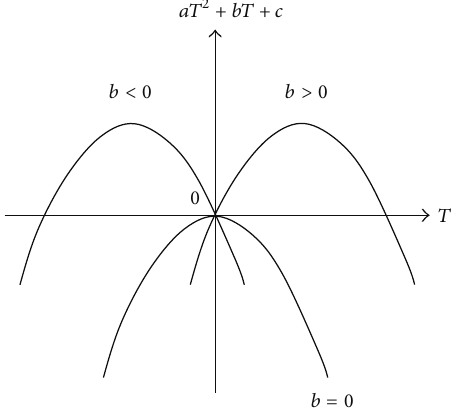
Figure 1: The relationship between 𝑎𝑇 2 + 𝑏𝑇 + 𝑐 and 𝑇 .